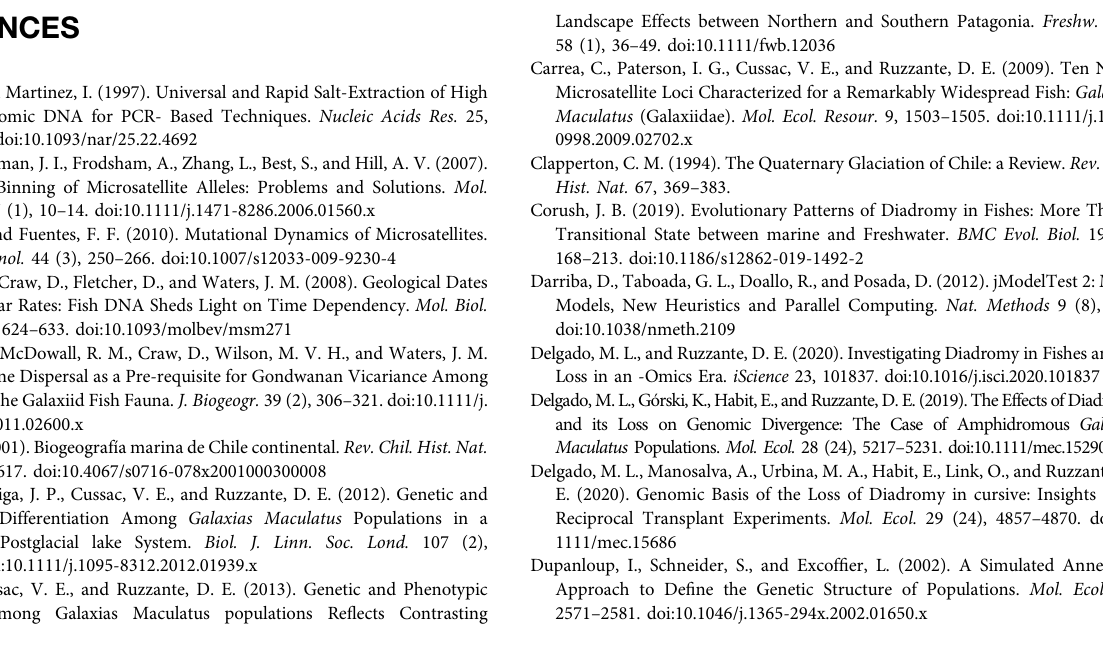
Supplementary Figure S1 | Bayesian maximum clade credibility tree of Galaxias maculatus haplotype relationships based on D-loop sequences. Bayesian posterior probabilitiesareshownabove thenodes. Coloredcircles indicate samplinglocalities of the specimens analysed. Main haplogroups (HI, HIII, and HIV) recorded in G. maculatus are also